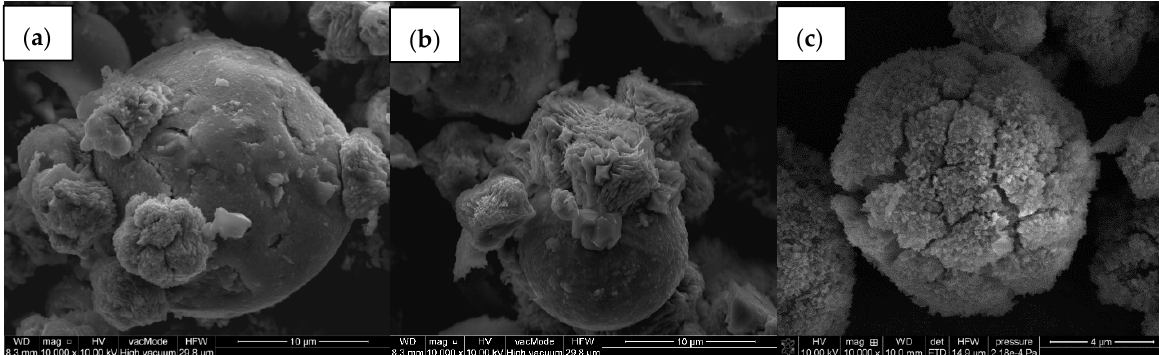
Figure 4. SEM photomicrographs of the ( a ) NaP1, ( b ) NaP1CS and ( c ) NaP1H (magnification 10,000×).